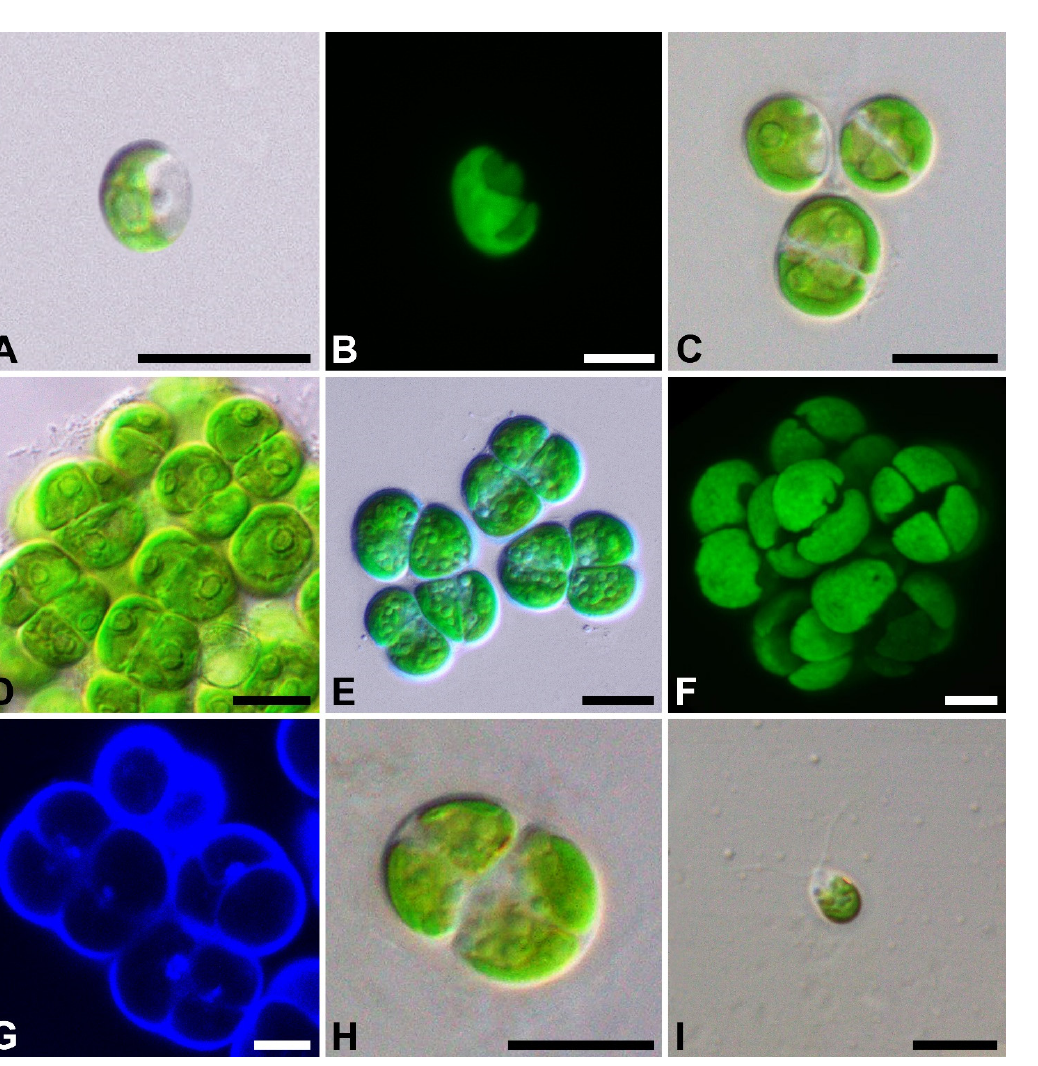
Figure 1. Light micrographs of general morphology ( A , C – E , H , I ), confocal reconstruction of chlo- roplast morphology ( B , F ), and confocal optical section of the nucleus ( G ) with bright-field image merged fluorescens channel in U. terrestrica . ( A , B ) young cells; ( C ) mature solitary cells; ( D – F ) mature cells in sarcinoid-like two- and three-dimensional packages; ( G ) cells with a nucleus stained with DAPI; ( H ) zoospores’ formation; ( I ) zoospore. Scale bars: ( A , C – E , H , I ) = 10 μ m; ( B , F , G ) = 5 μ m.